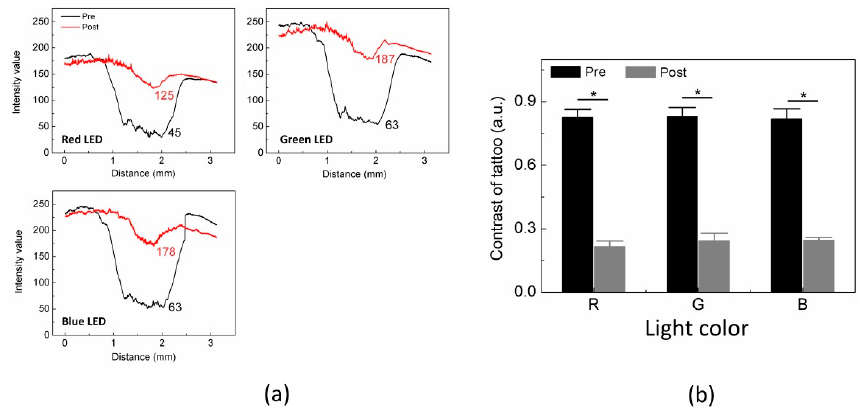
Figure 3. Comparison of black tattoo from pre and post treatment under three LED colors: ( a ) intensity value and ( b ) contrast (N = 10; * p < 0.001).